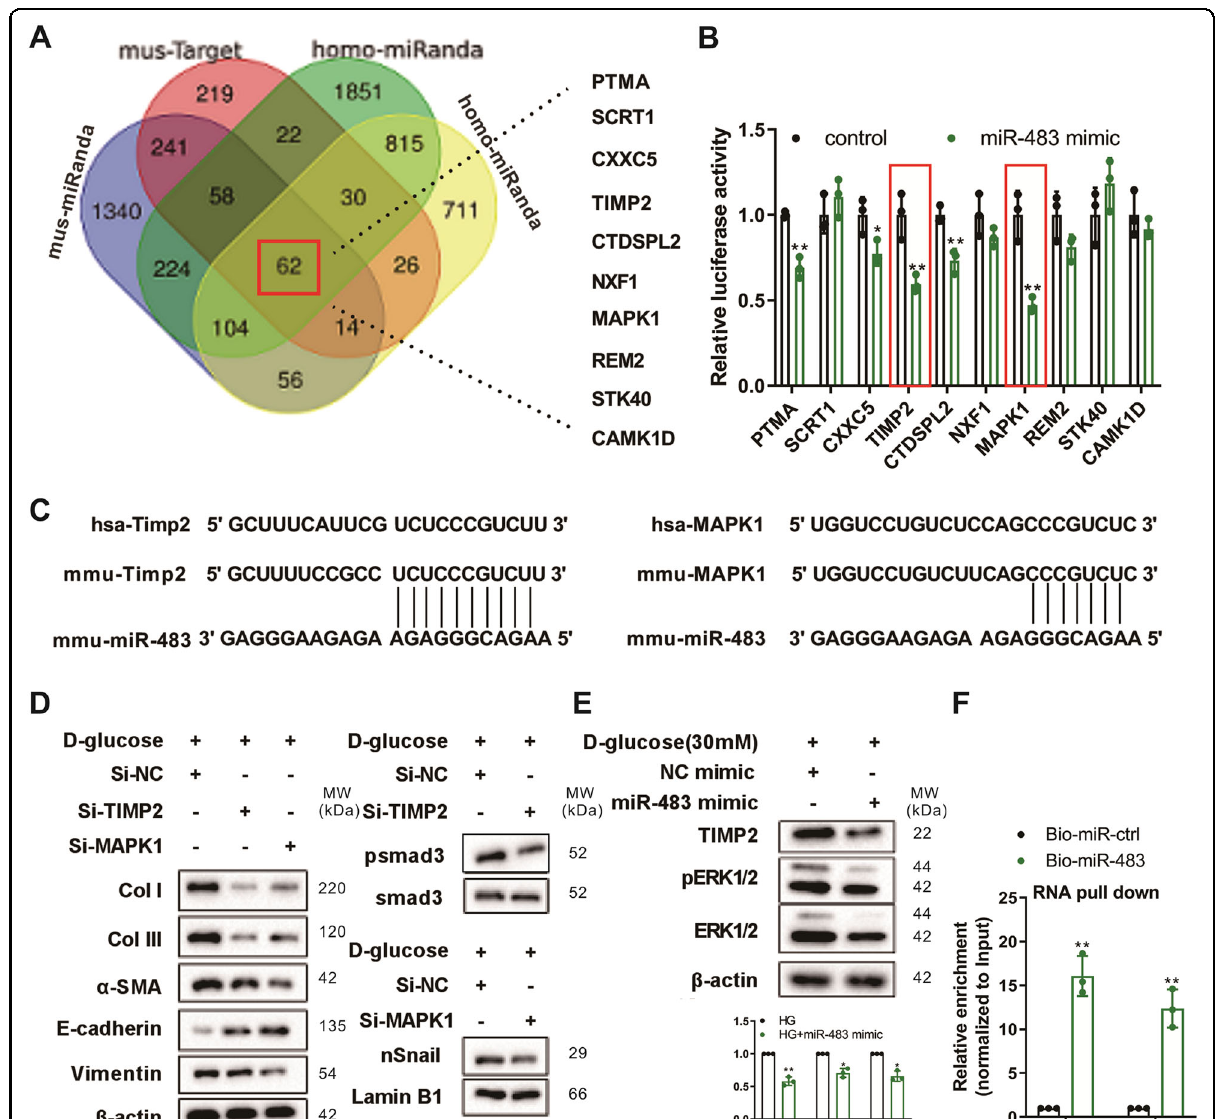
Fig. 3 Effect of TIMP2 and MAPK1 on the regulation of miR-483-5p on renal TECs under HG conditions. A TargetScan and miRanda databases were applied to predict target genes that were ef fi ciently bound to miR-483-5p both in mice and humans. B The top 10 genes (PTMA, SCRT1, CXXC5, TIMP2, CTDSPL2, NXF1, MAPK1, REM2, STK40, and CAMK1D) with strong conservative software prediction scores were applied to conduct the dual- luciferase reporter gene assay. C The binding sites of miR-483-5p and TIMP2, miR-483-5p and MAPK1 in mice and humans. D After transfecting si-TIMP2, si-MAPK1 into TCMK-1 cells, the cells were treated with 30 mM HG for 48 h. Detection of CoL I, CoL III, α -SMA, E-cadherin, Vimentin, Smad3, and nSnail protein levels by western blot. E After transfecting miR-483-5p mimic into TCMK-1 cells, the cells were treated with HG. Detection of TIMP2, ERK1/2 (MAPK1 encoding protein), and pERK1/2 protein levels by western blot. F RNA pull-down experiments corroborated that miR-483-5p bound to the 3 ′ UTR region of TIMP2 and MAPK1, respectively. * P < 0.05 vs. HG or control. ** P < 0.01 vs. HG, control or Bio-miR-ctrl. Student ’ s t -test. of three independent experiments. nSnail Snail in the nucleus, NC negative control, HG high glucose, ctrl